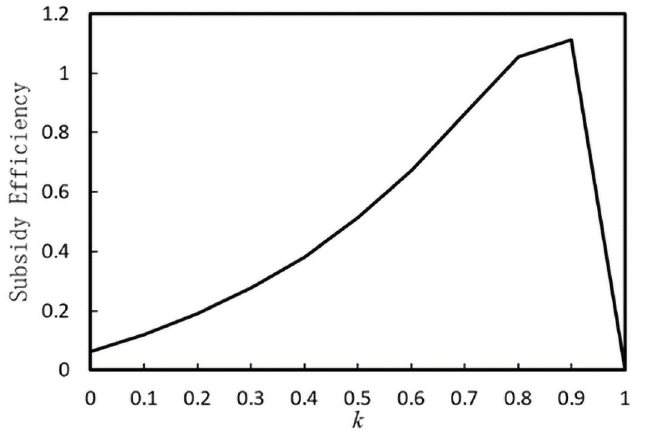
Fig 6. The impact of k on the subsidy